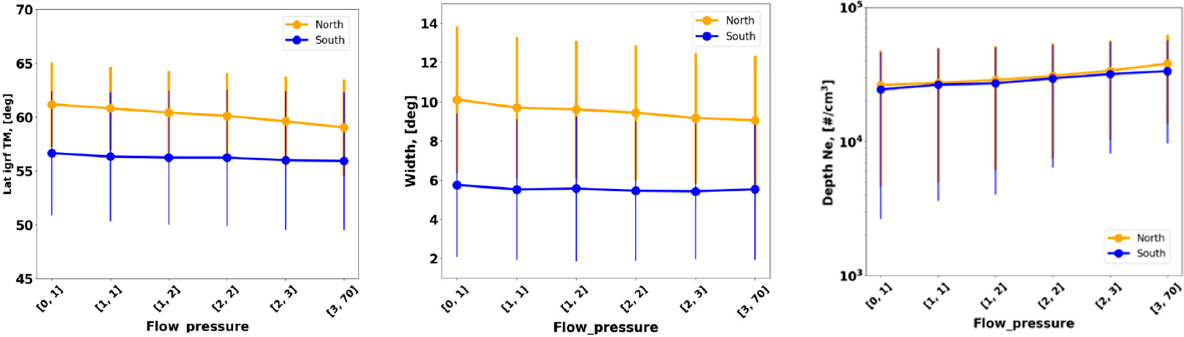
Figure 16. Flow pressure dependence of the trough minimum position, trough width, and trough depth for the northern and southern hemispheres.